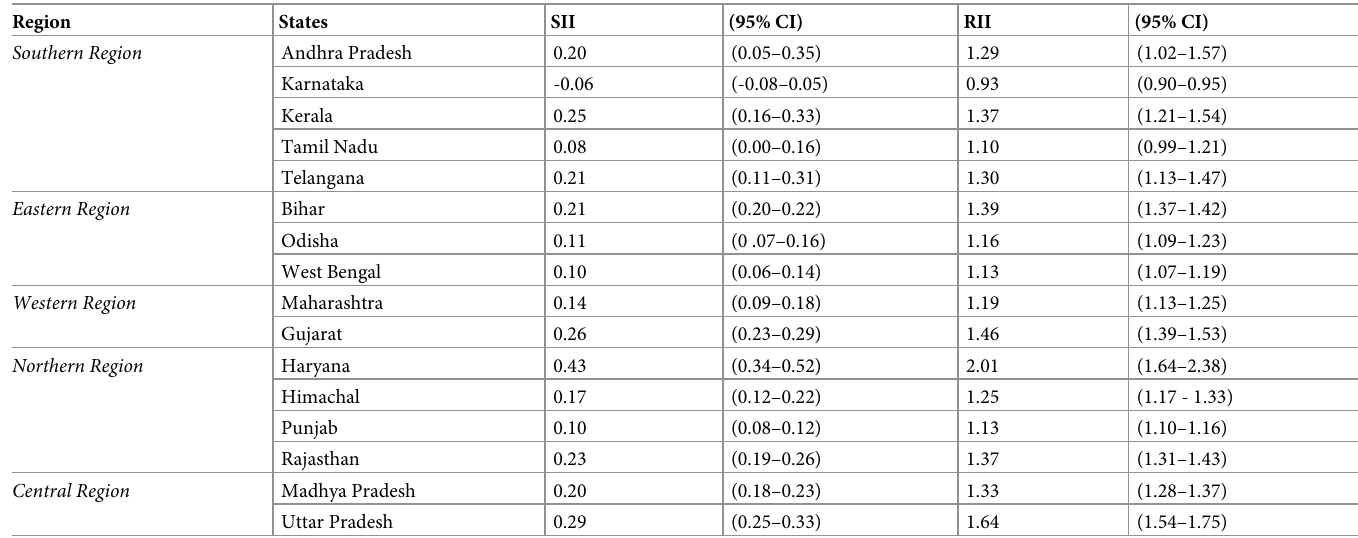
Table 3. SII and RII of composite coverage index across major Indian states. Region